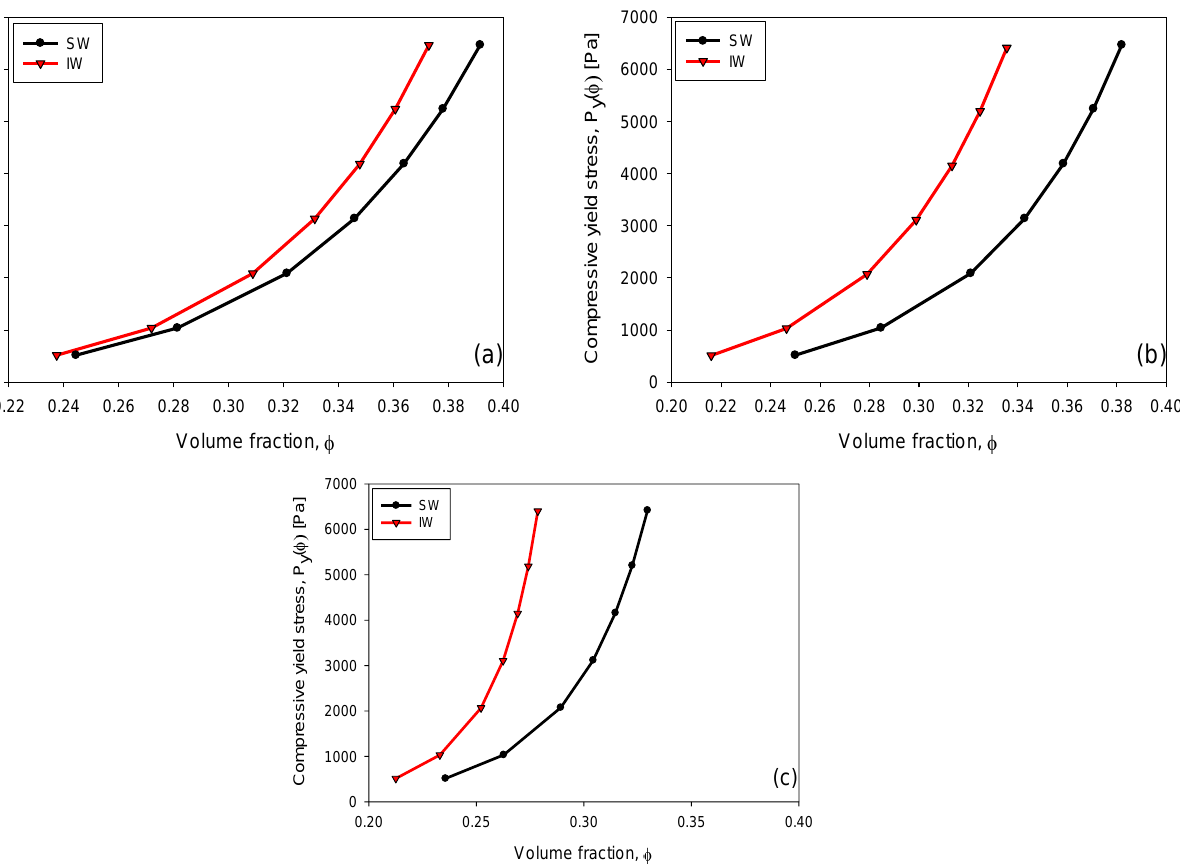
Figure 12. Variation of compressive yield stress versus volume fraction of kaolin suspensions in IW and SW with flocculant doses ( a ) 50 g/t, ( b ) 75 g/t, and ( c ) 100 g/t. Shear rate 180 rpm, solid concentration 5 wt%, flocculation time 15 s, and pH 7. Table 3. Power law parameters ( c and n ) and goodness of fit ( R 2 ) for the compressive yield stress of kaolin suspensions with three flocculant doses in SW and IW.